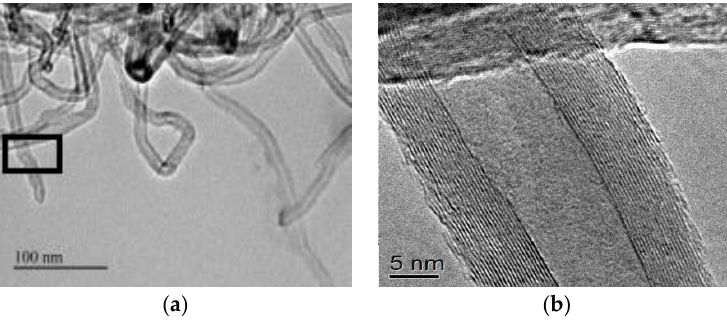
Figure 1. TEM of CNTs. ( a ) aggregate of CNTs ( b ) multi-walled CNT. Table 1. Physical and mechanical properties of multi-walled carbon nanotubes. Type Multi-walled carbon